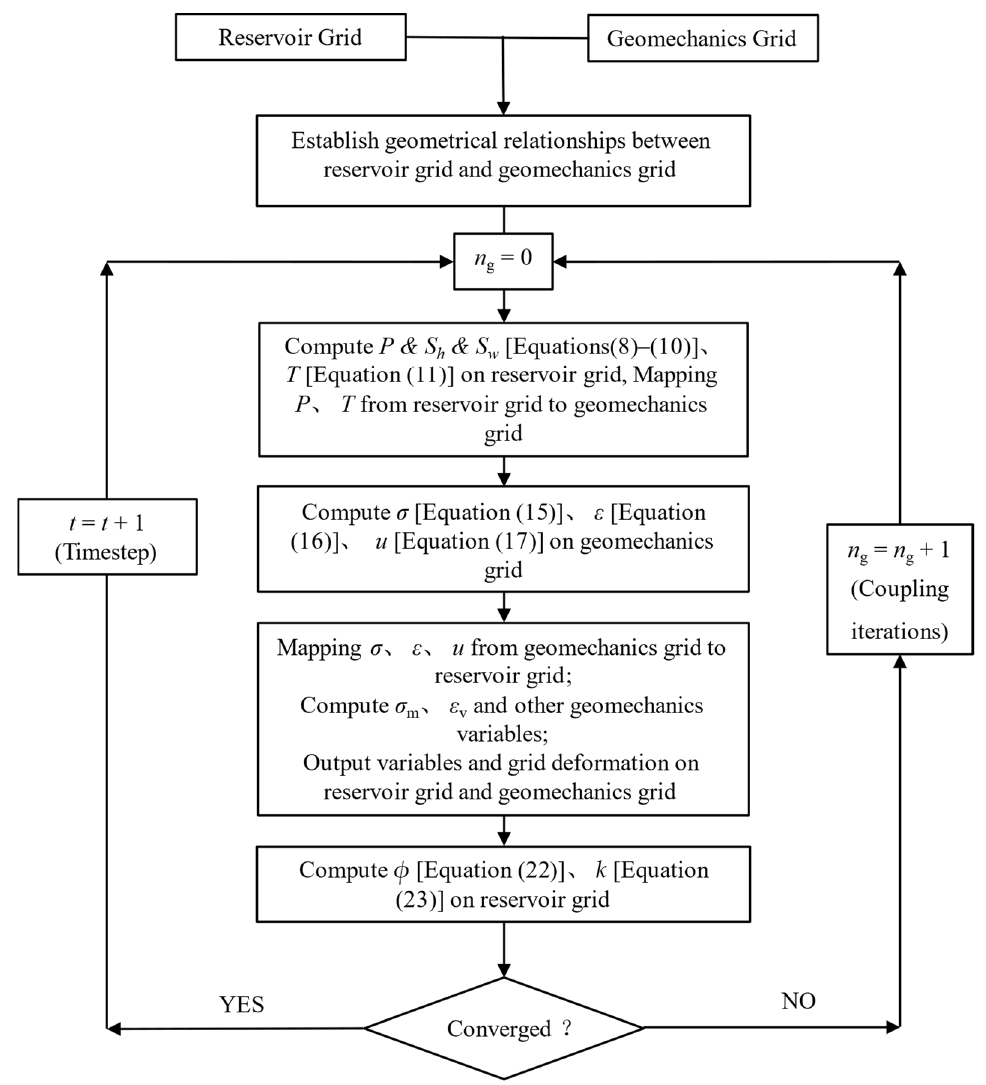
Figure 2. Flow chart of the iterative solution approach of the THMC model.